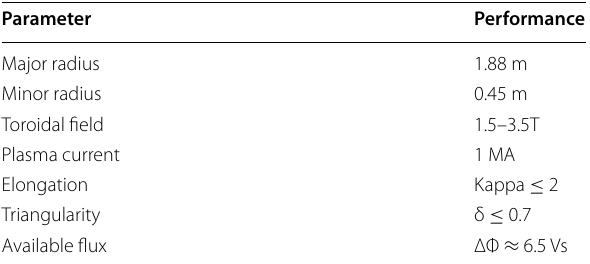
Table 1 Main design parameters of the EAST device